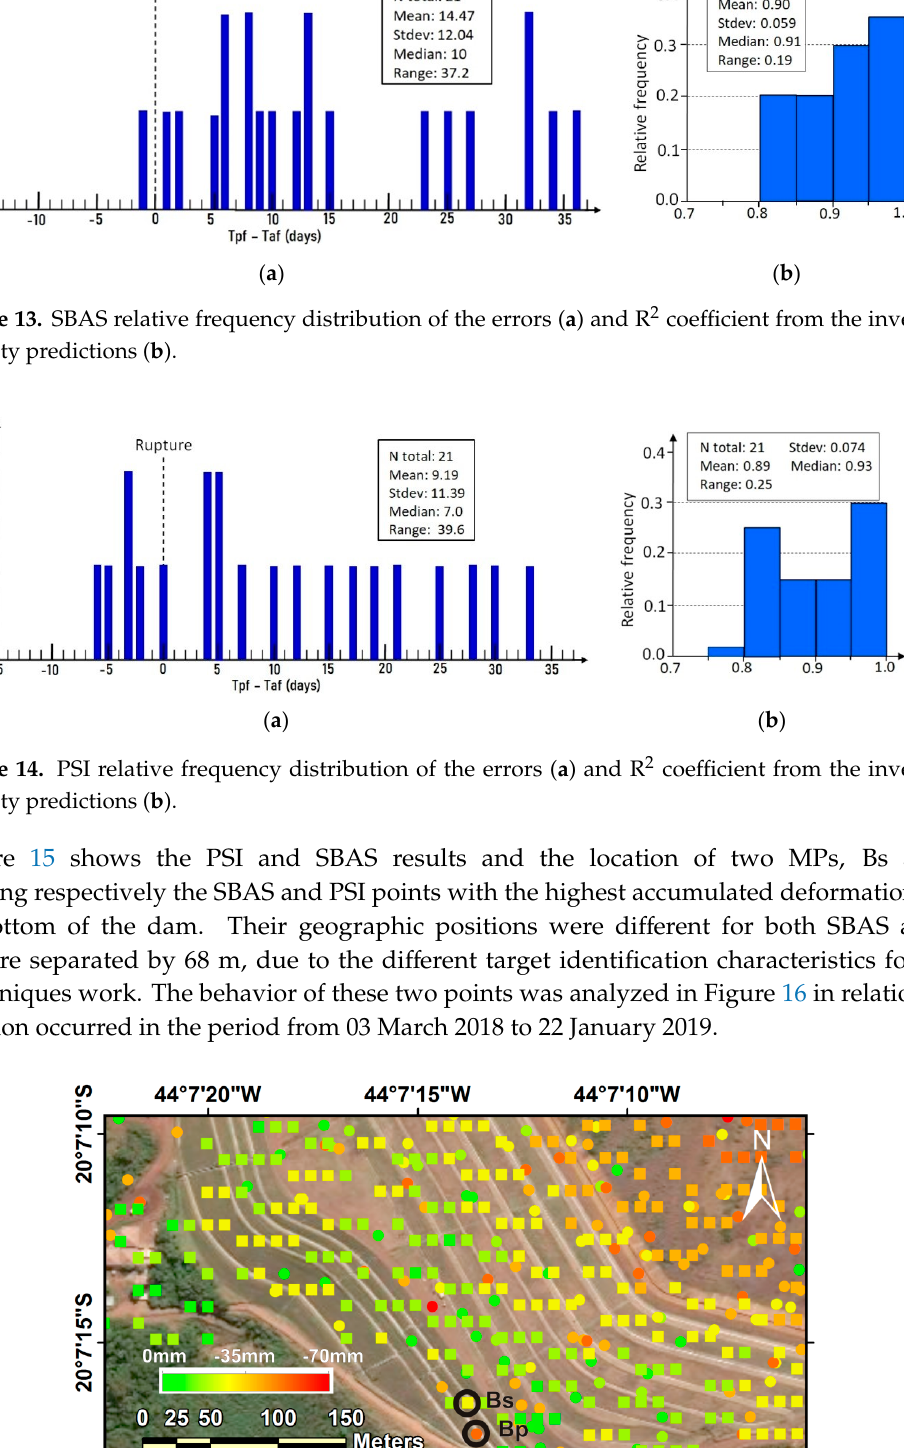
2 coefficients distributions from the inverse velocity predictions can be seen in